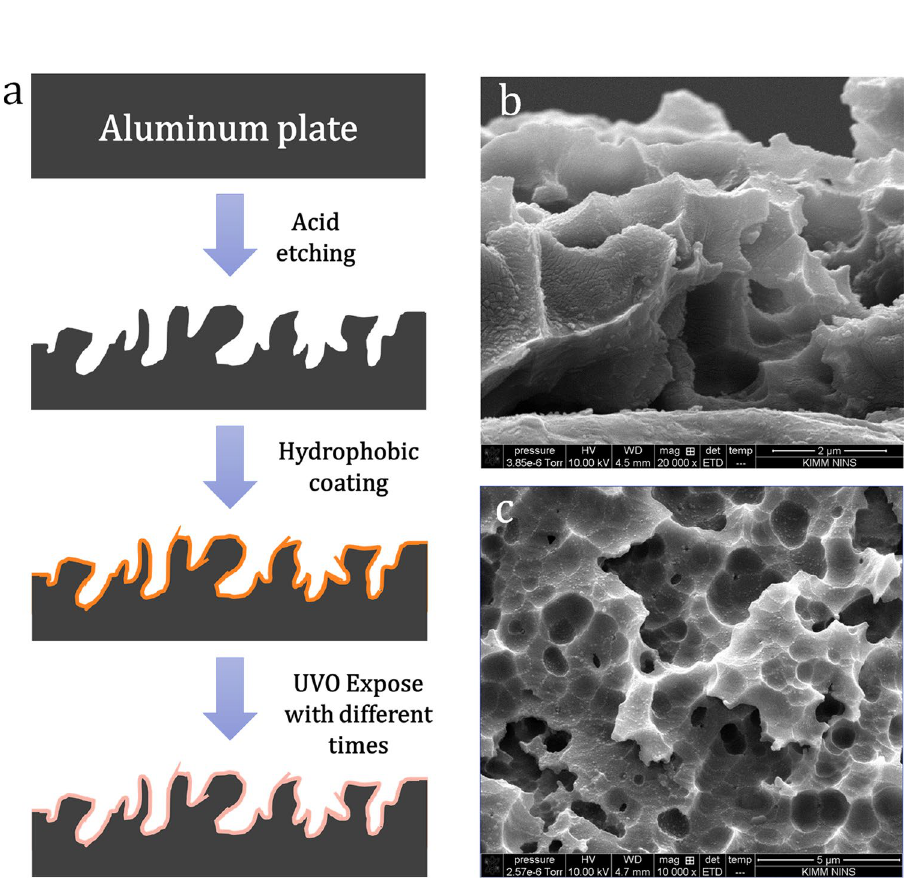
Figure 6. The fabrication process of examined samples ( a ) and SEM images of the surface after etching in cross-view ( b ) and top view ( c ). Reproduced with permission from Nguyen et al. 24 , © 2018 The Korean Society of Industrial and Engineering